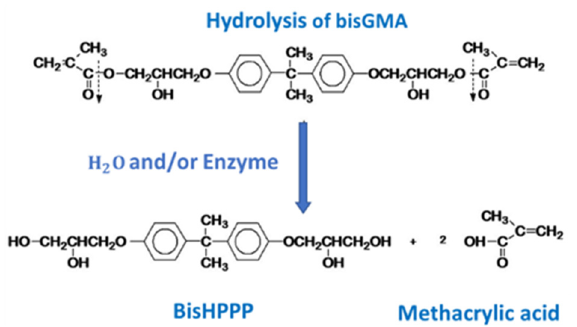
Figure 4. The hydrolysis of BisGMA. The carboxylic acid groups (which connect the bulk of the molecule to the ester linkages that integrate it into the resin network) are hydrolyzed, releasing the bulk of the molecule, and removing a crosslink between polymer chains.